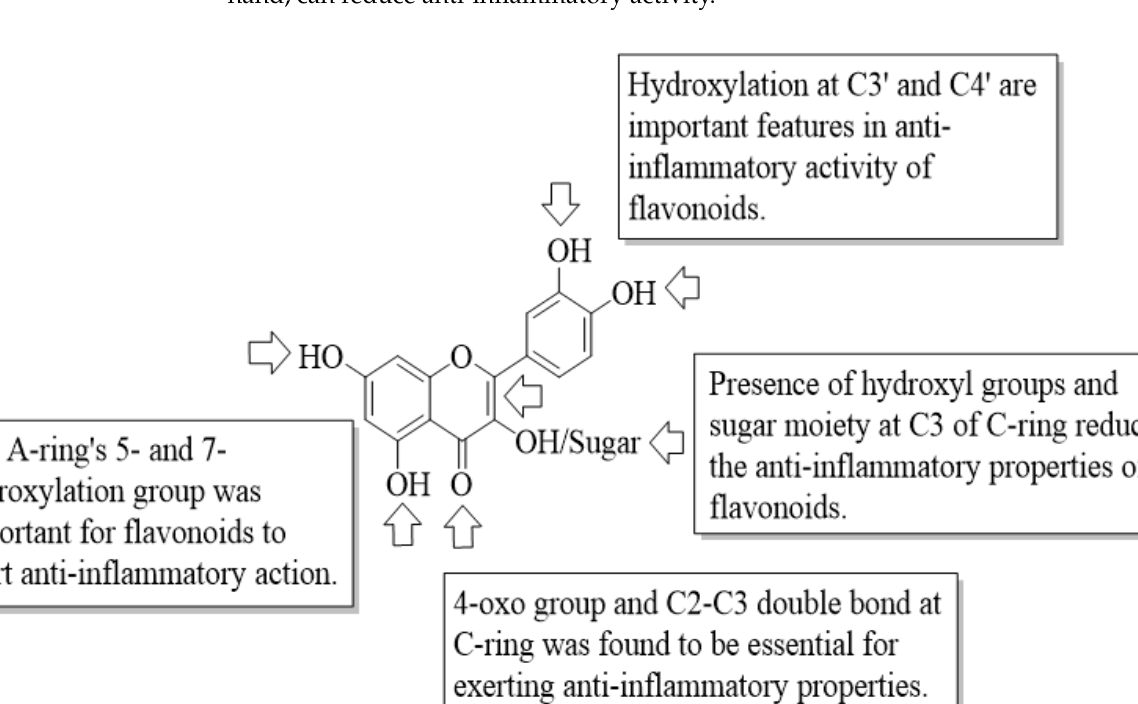
Figure 29. The SAR of flavonoids as anti-inflammatory agent.